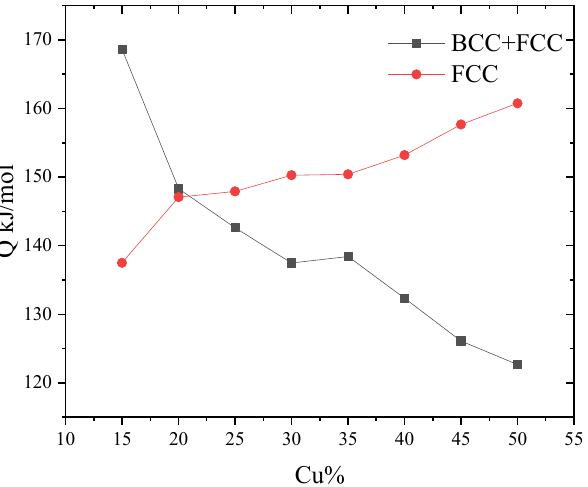
Figure 9. The diffusion activation energy for different Cu concentrations.